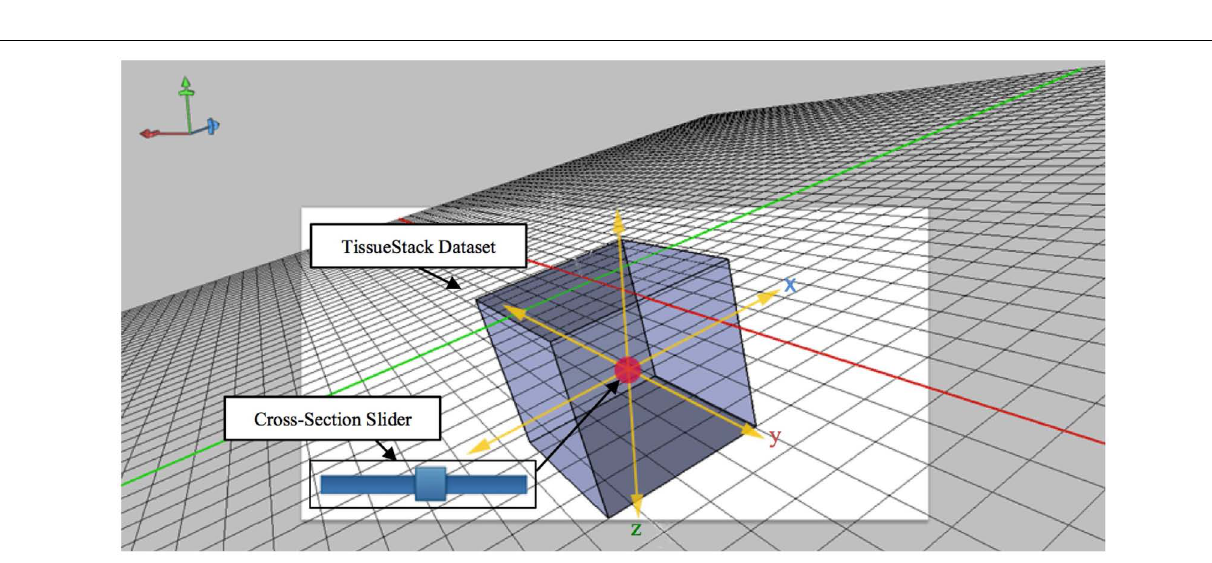
FIGURE 5 | Cross-section slider for viewing any plane defined by two of the axes along a third axis orthogonal to aforementioned plane